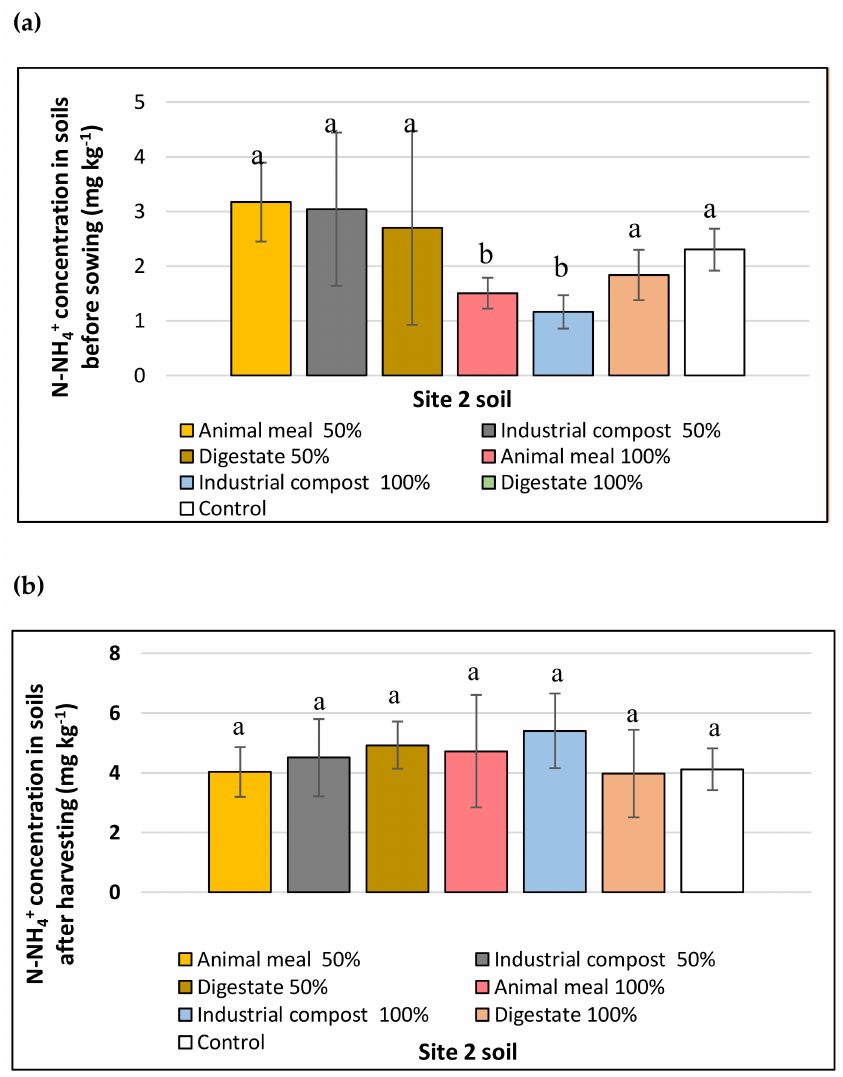
Figure 2. The contents of extractable N-NH 4 + in the Site 2 soils in relation to the control; ( a ) soil before sowing; ( b ) soil after harvesting. Lowercase letters indicate significant di ff erences between the treatments, calculated separately for individual sites based on Tukey’s test. Means marked with the same letter did not di ff er significantly ( p <